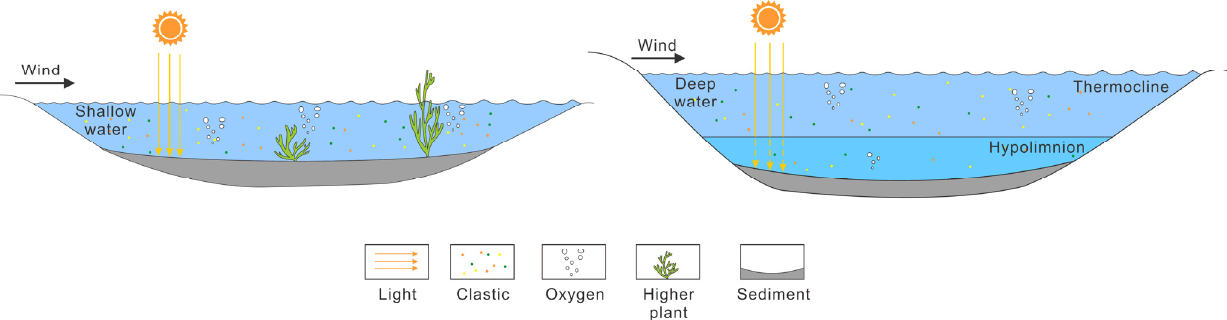
Figure 12. Schematic diagram of shallow and deep water environment.